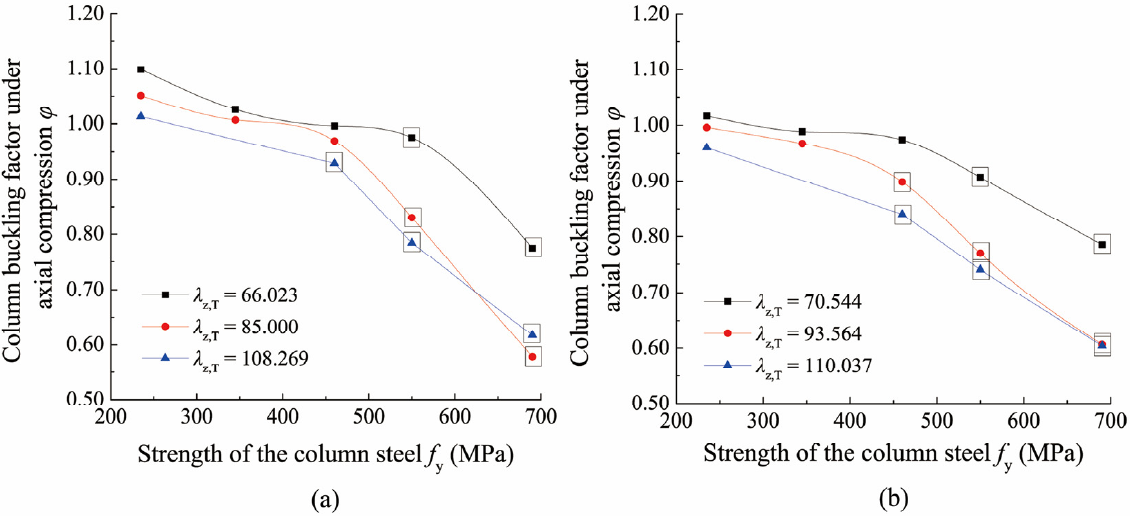
Figure 19. Relationship between column buckling factor and yield strength of the column steel for varying torsional slenderness ratio: ( a ) Model M2- λ z ,T , ( b ) Model M6- λ z ,T . When column buckling occurs, the overall torsional stiffness of the column